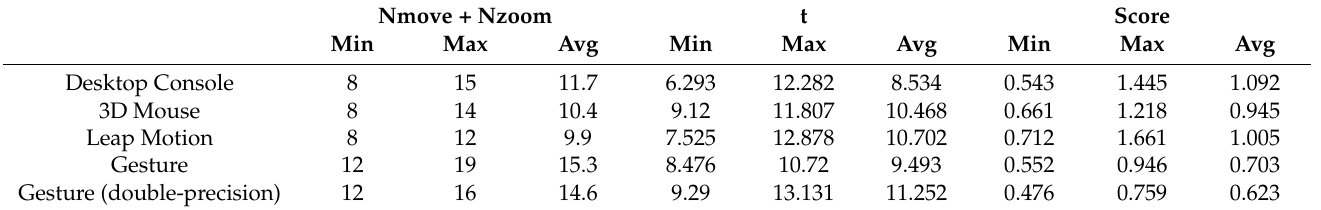
Table 5. Statistics table of navigation tasks.